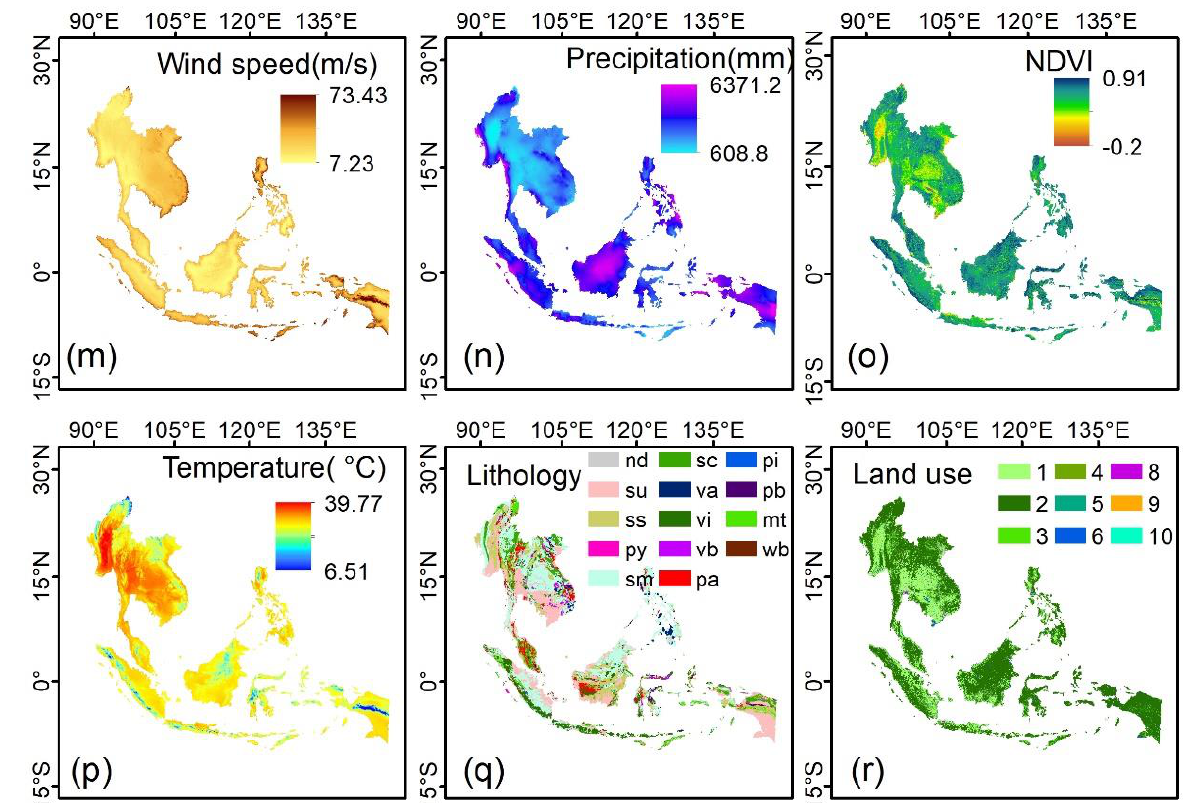
Figure 2. Conditioning factors used in this paper: ( a ) elevation, ( b ) slope angle, ( c ) aspect, ( d ) plan curvature, ( e ) profile curvature, ( f ) distance to urban areas, ( g ) distance to rivers, (h) distance to roads, ( i ) distance to faults, ( j ) SPI, ( k ) TWI, ( l ) soil moisture, ( m ) wind speed, ( n ) mean annual precipitation, ( o ) NDVI, ( p ) mean annual maximum temperature, ( q ) lithology and ( r ) land use. NOTE: In ( q ): su, Unconsolidated sediments; ss, Siliciclastic sedimentary rocks; py, Pyroclastics; sm, Mixed sedimentary rocks; sc, Carbonate sedimentary rocks; ev, Evaporites; va, Acid volcanic rocks; vi, Intermediate volcanic rocks; vb, Basic volcanic rocks; pa, Acid plutonic rocks; pi, Intermediate plutonic rocks; pb, Basic plutonic rocks; mt, Metamorphics; wb, Water Bodies; ig, Ice and Glaciers and nd, No Data. In ( r ): (1) Cropland, (2) Forest, (3) Grassland, (4) Shrubland, (5) Wetland, (6) Water, (7) Tundra, (8) Impervious surface, (9) Bareland and (10) Snow/Ice. Table 2. Separate factors used for landslide and wildfire susceptibility modeling. Factors